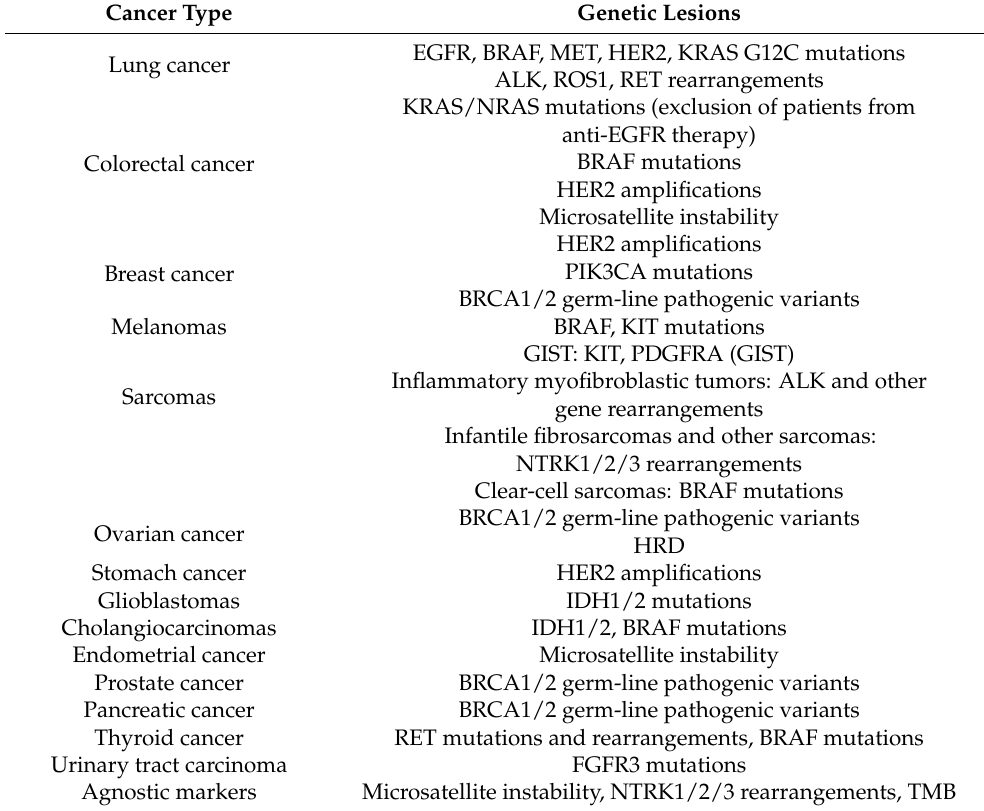
Table 1. Examples of predictive mutation tests utilized in clinical oncology. Cancer Type Genetic Lesions Lung